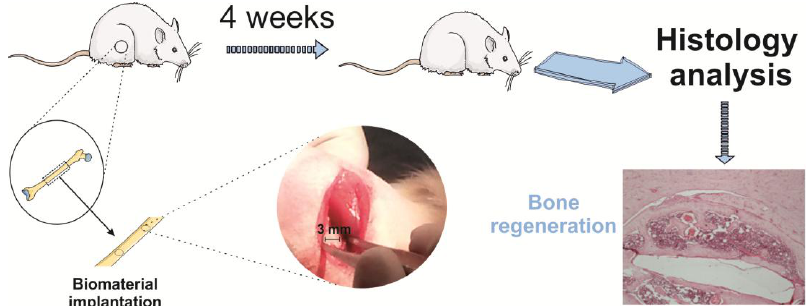
Figure 3. Graphical representation of the biomaterial implantation surgery protocol and representative section of Hematoxylin and Eosin (H&E) staining the healing defects 4 weeks after implantation on a poled β-PVDF film. Reproduced with permission [203].